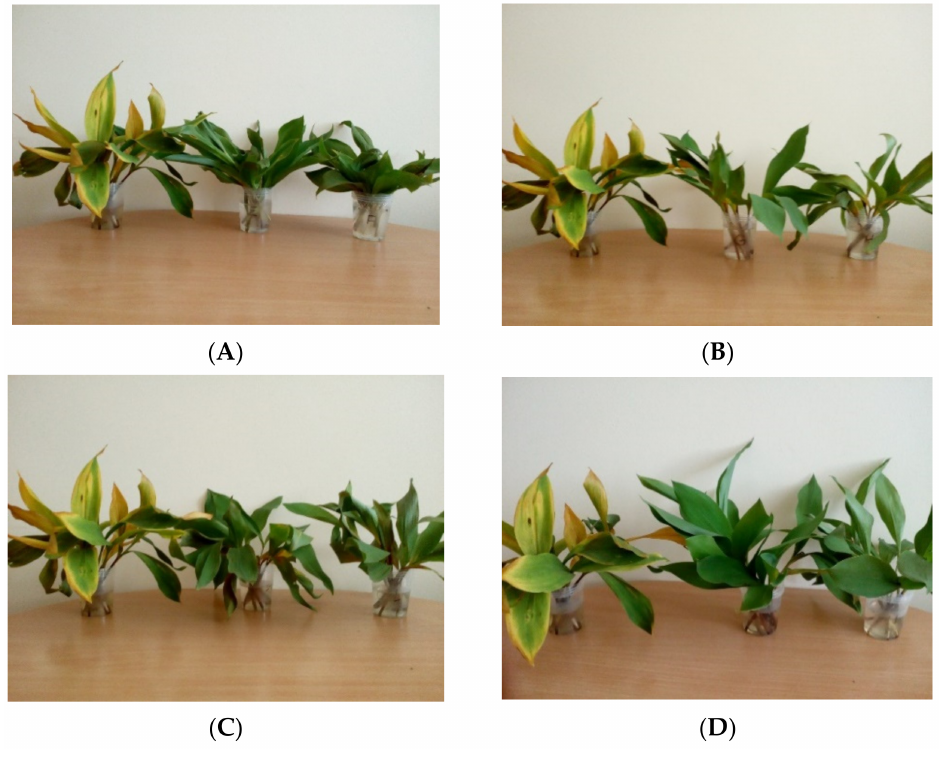
Figure 3. Leaves of Convallaria majalis 8 days after conditioning and insertion into water. ( A )—from left: control leaves, conditioned in [Q-C 12 ][Gib] at concentration of 50 and 100 mg dm − 3 ; ( B )—from left: control leaves, conditioned in [Gib][Ach] at concentration of 50 and 100 mg dm − 3 ; ( C )—from left: control leaves, conditioned in [Q-C 2 ][Gib] at concentration of 50 and 100 mg dm − 3 ; ( D )—from left: control leaves, conditioned in [Q-C 12 ][Gib] at concentration of 50 and 100 mg dm − 3